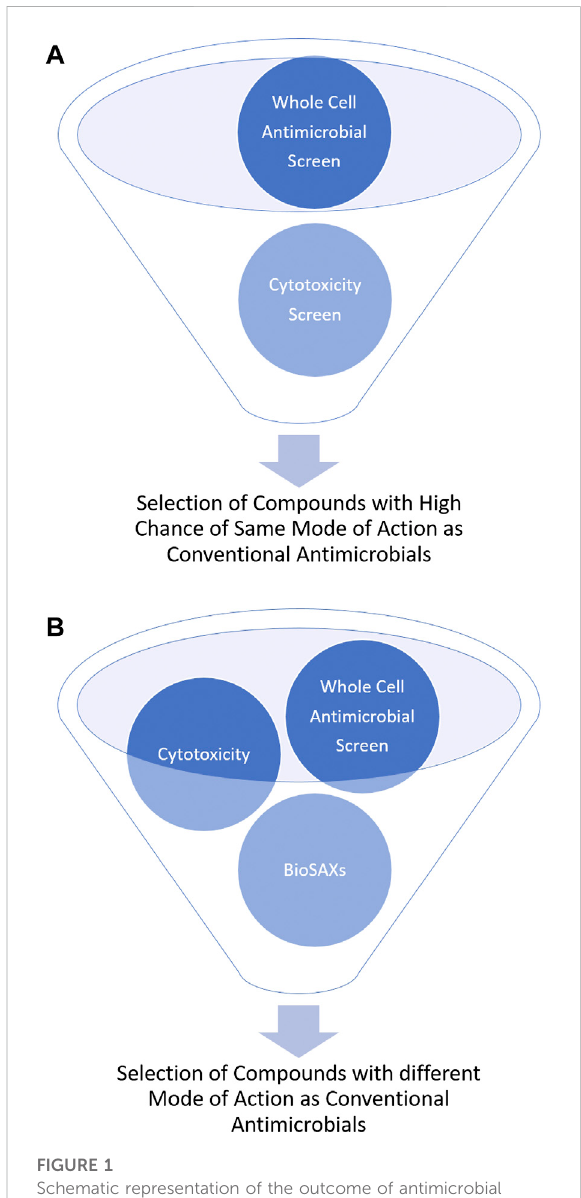
FIGURE 1 Schematic representation of the outcome of antimicrobial drug development without (A) and with BioSAXS (B) as an additional screening